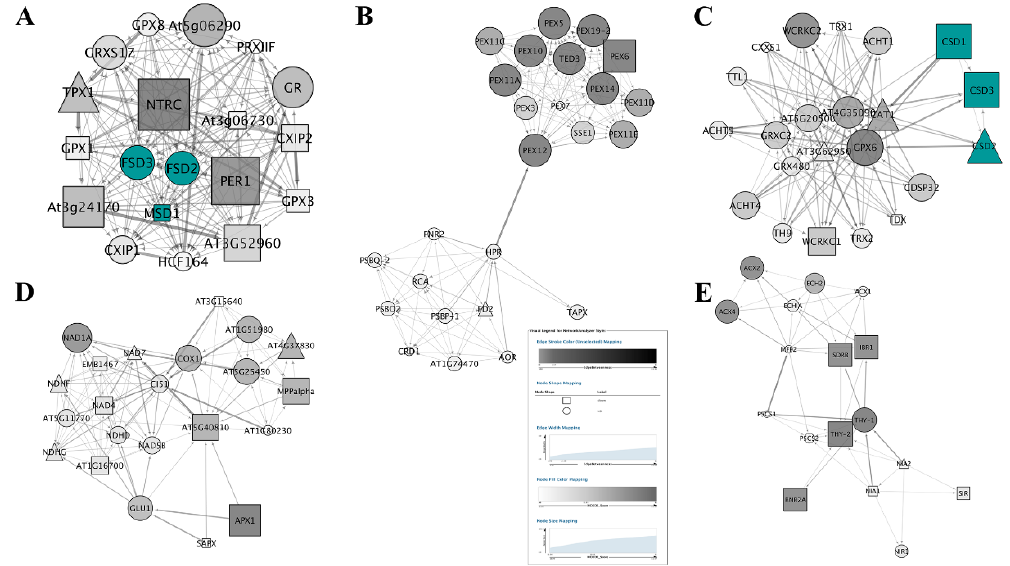
Figure 5. Top 5 clusters of ROS related PPI network calculated by MCODE. ( A – E ) represents cluster 1–5, respectively. SODs were colored in ( A,C ).